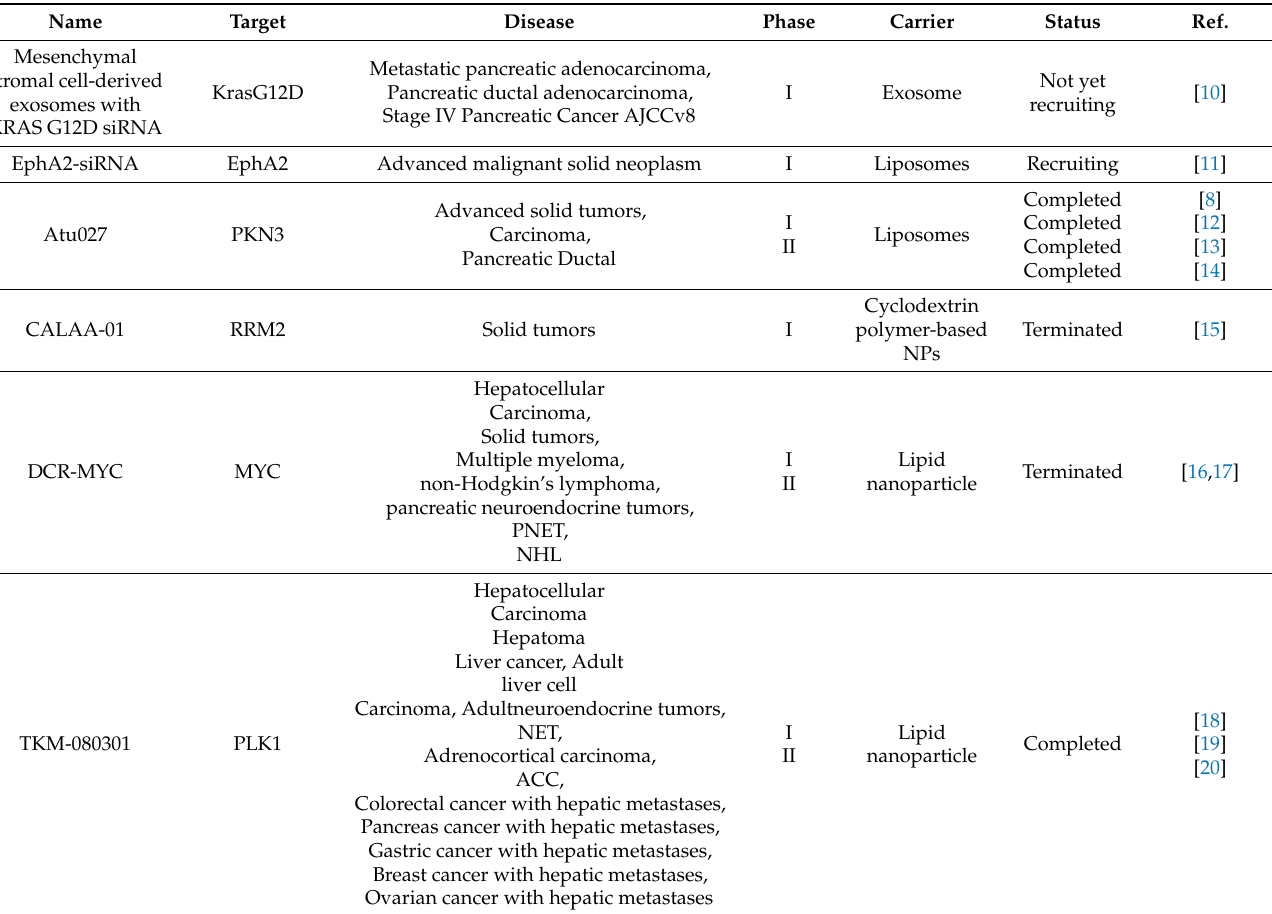
Table 1. Clinical trials with RNAi-based therapies (Available online: https://clinicaltrials.gov, accessed on 20 November 2020).